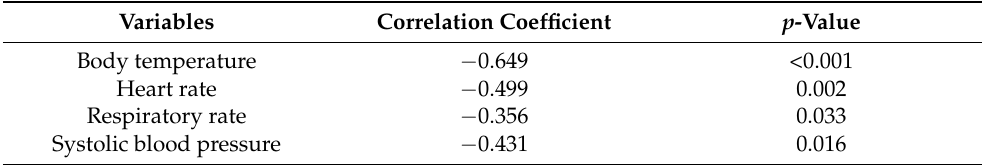
Table 3. Correlation between partial venous pressure of carbon dioxide and basic